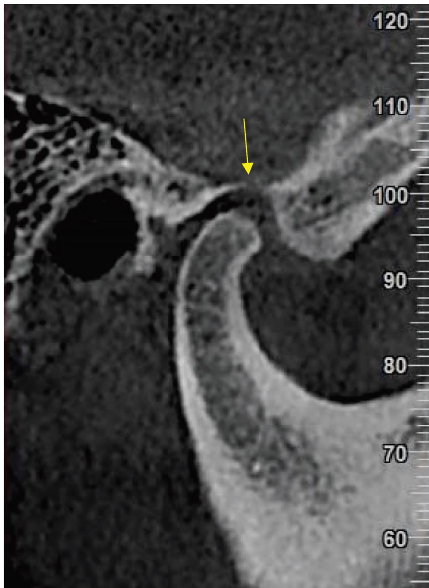
Figure 3: Dehiscence of the roof glenoid fossa (RGF) on the sagittal section (yellow